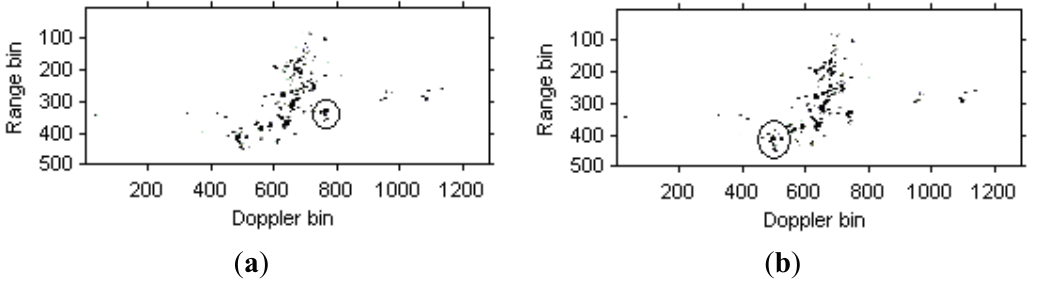
Figure 14. Time frequency representations for the received signal in a range bin. ( a ) WVD for the original signal; ( b ) WVD for the LFM signal component; ( c ) WVD for the Chirplet component; ( d ) WVD for the modified version of Chirplet component.